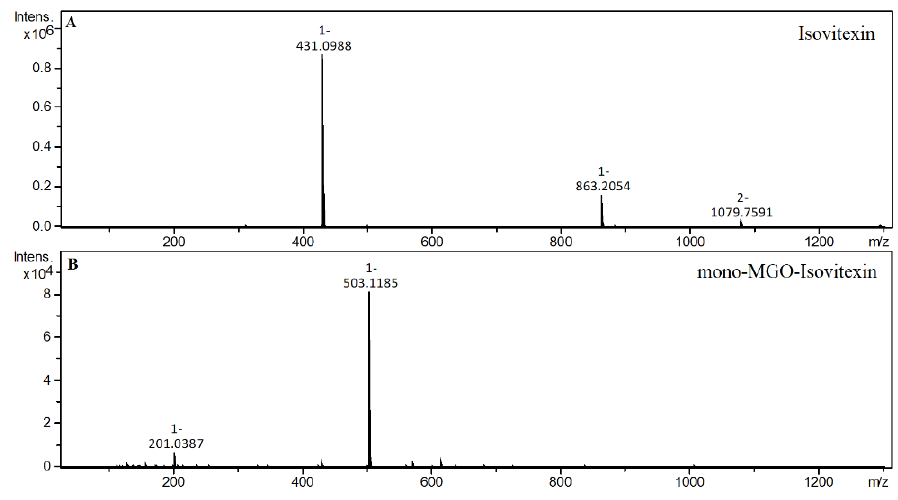
Figure 10. Mass spectra of isovitexin and its methylglyoxal adduct after 1 h of incubation in pH 7.4 phosphate buffer solution at 37 °C; ( A ), isovitexin; ( B ), mono-MGO-isovitexin.